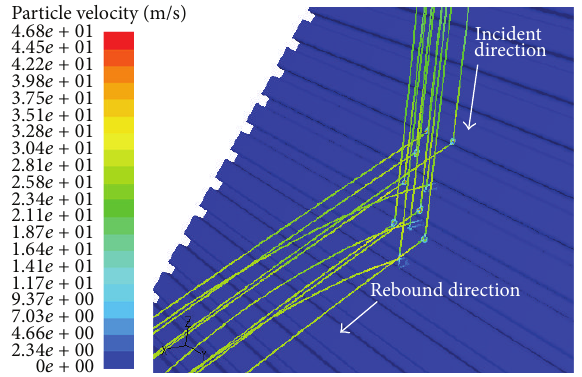
Figure 11: The trajectories of particle collision groove surface.